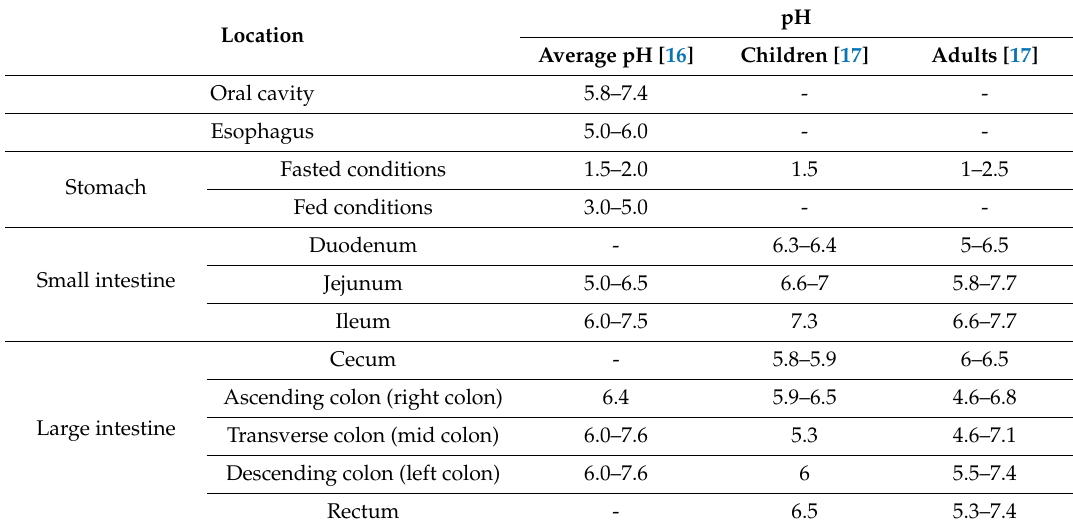
Table 1. pH profile along the gastrointestinal